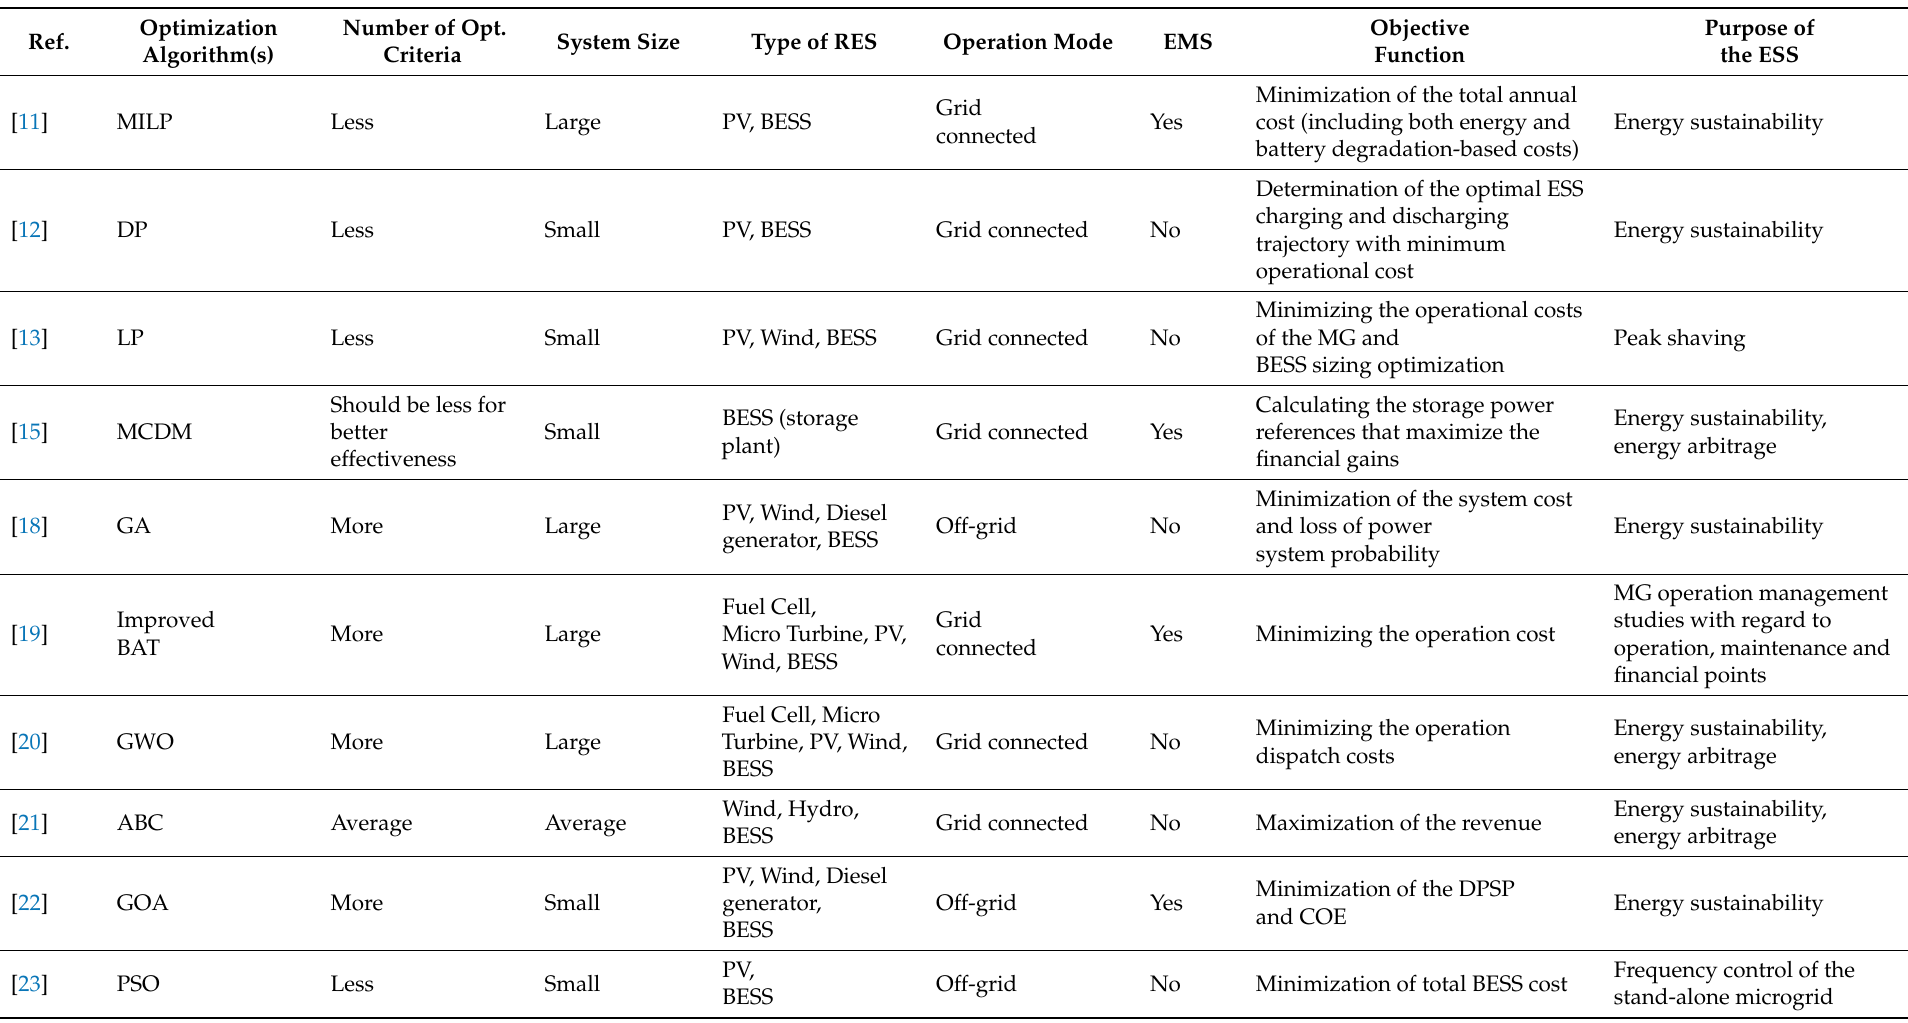
Table 3. Comparison of existing system and proposed